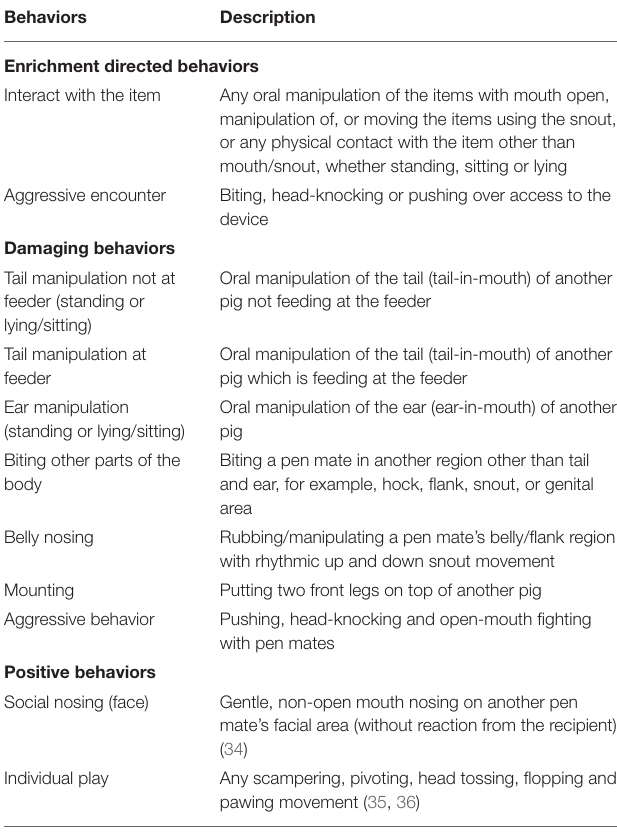
TABLE 3 | Ethogram for behavior observation adapted from (13).